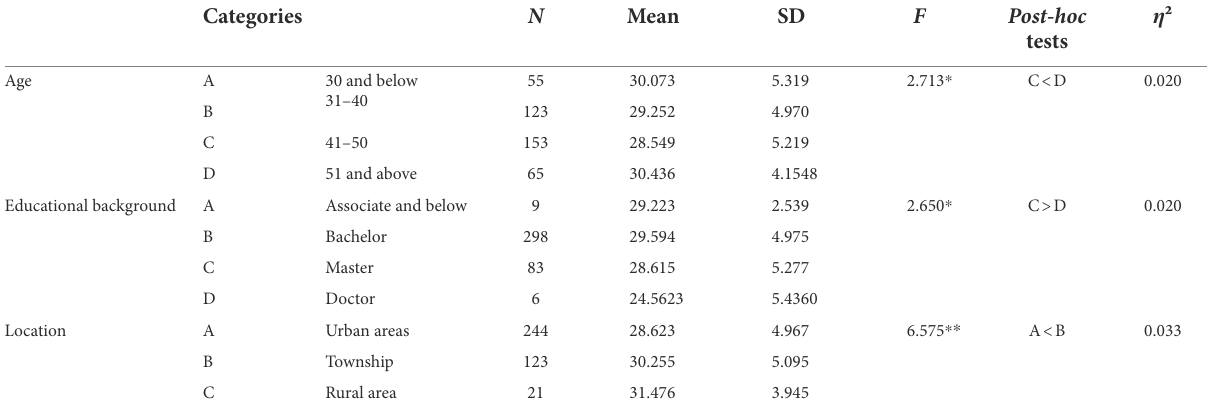
TABLE 5 One-way analysis of variance for teachers’ autonomous learning